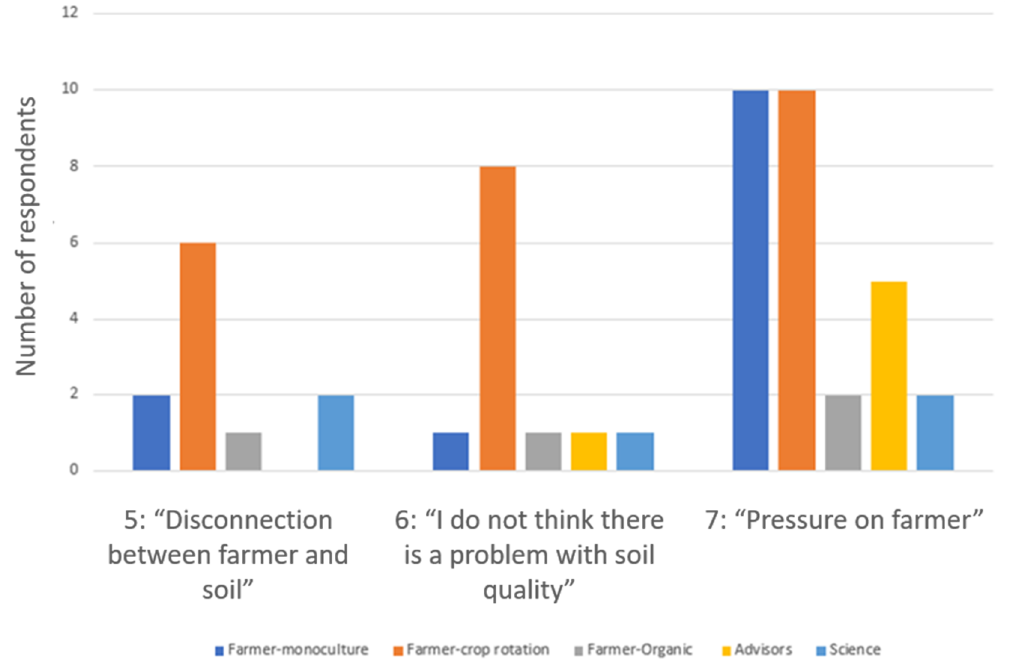
Figure 2. Professions of Norwegian respondents loading onto the three problem factor groups.